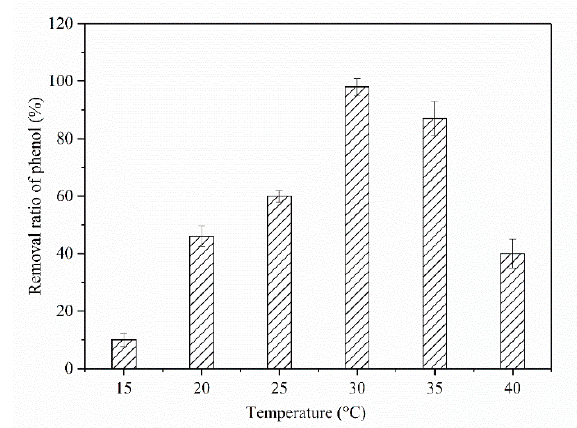
Figure 2. Effects of different temperatures on phenol degradation.